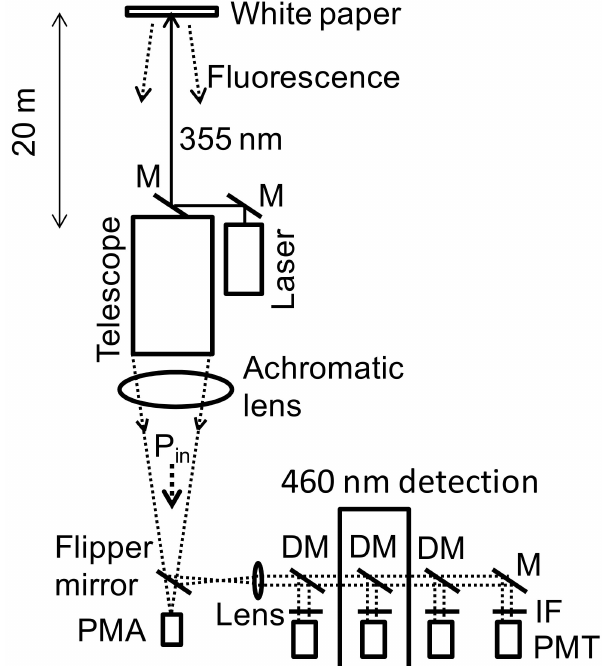
Figure 7. Configuration of comparative experiment, the PMA detection with the PMT detection. M: mirror. DM: dichroic mirror, IF: interference